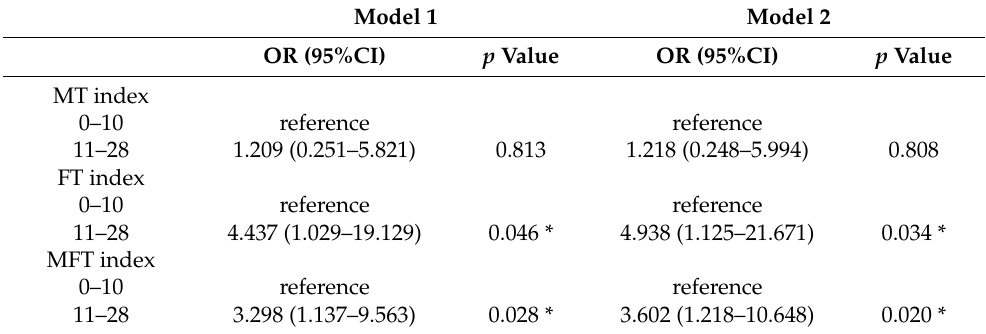
Table 3. ORs (95% CIs) for H. pylori infection by dental problems using logistic regression